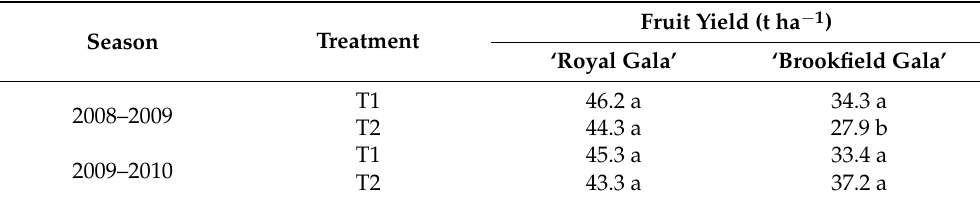
Table 3. ‘Royal Gala’ and ‘Brookfield Gala’ apple production for two water application treatments